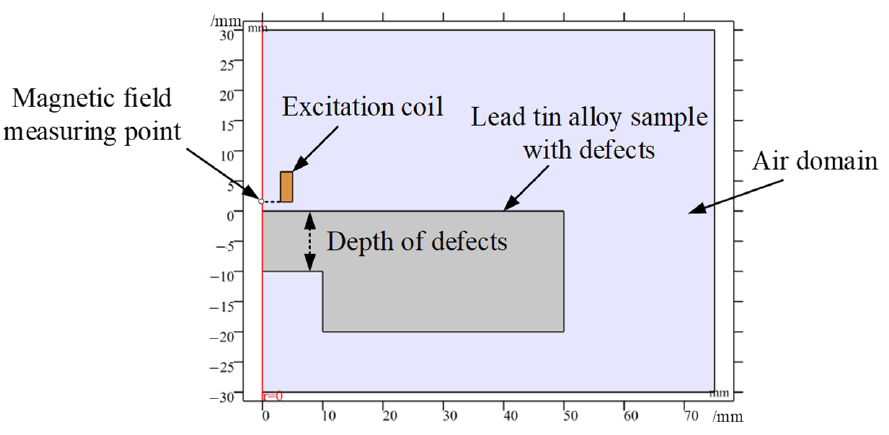
Figure 3. Simulation geometry model. Table 1. Table of mesh